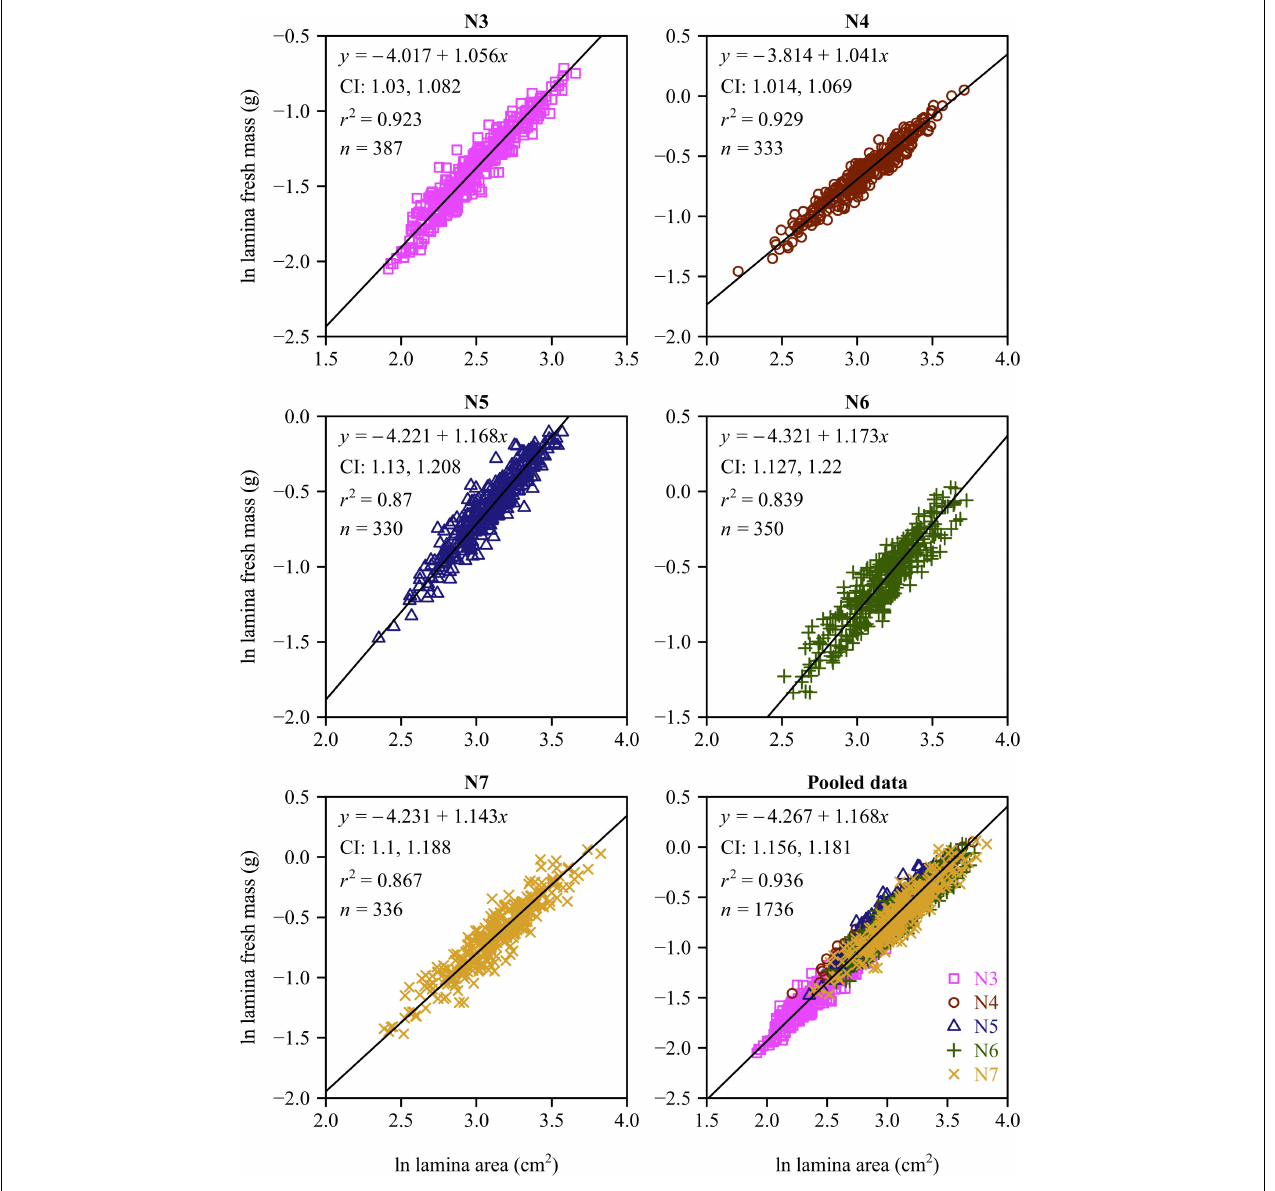
FIGURE 4 | Fitted scaling relationships between lamina fresh mass and lamina surface area for the five leaf-age groups. The small open circles represent the log-transformed values of lamina fresh mass vs. lamina surface area; the red straight lines represent the regression lines; CI represents the 95% confidence intervals of the slope; r 2 is the coefficient of determination; and n is the sample